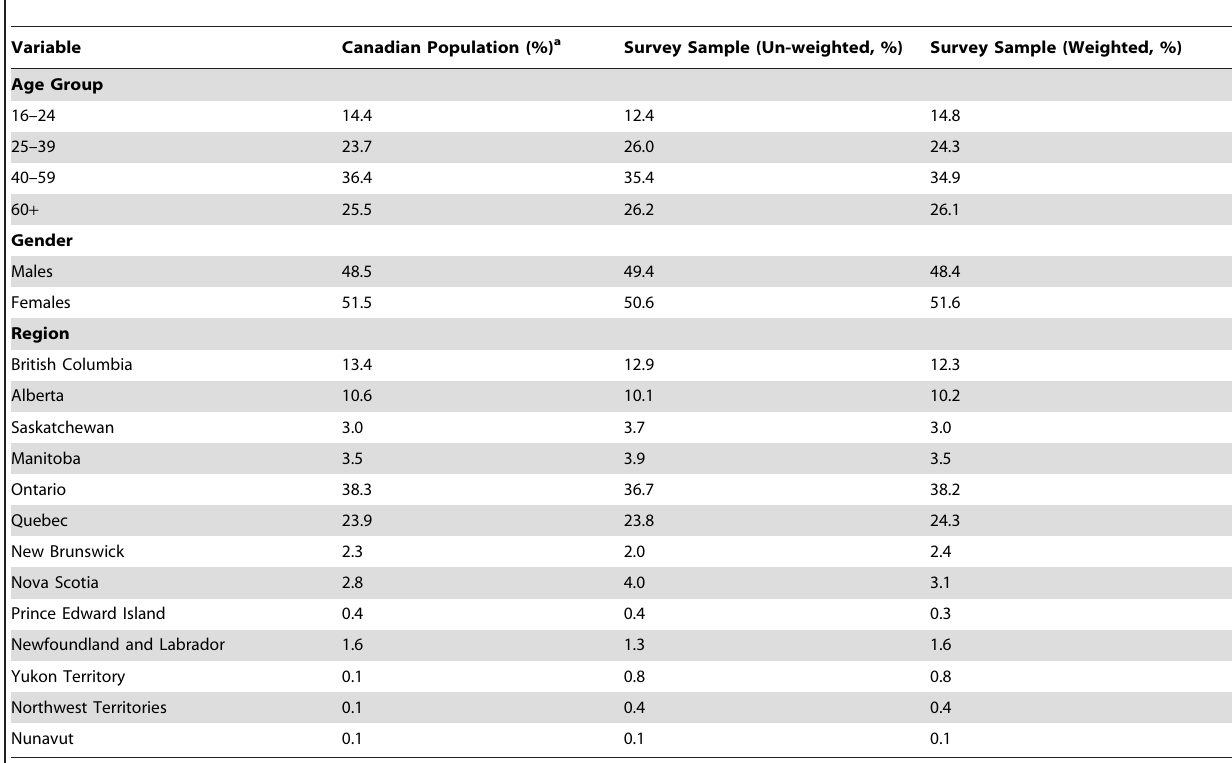
Table 1. Key variables from the general population in Canada, 16 years of age and older, compared to the un-weighted and weighted survey samples